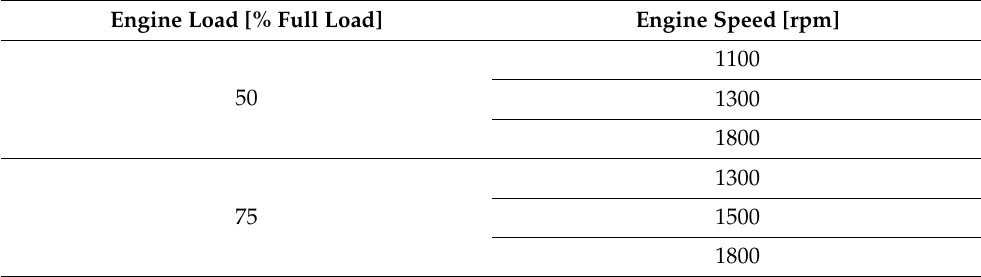
Table 6. Experiment